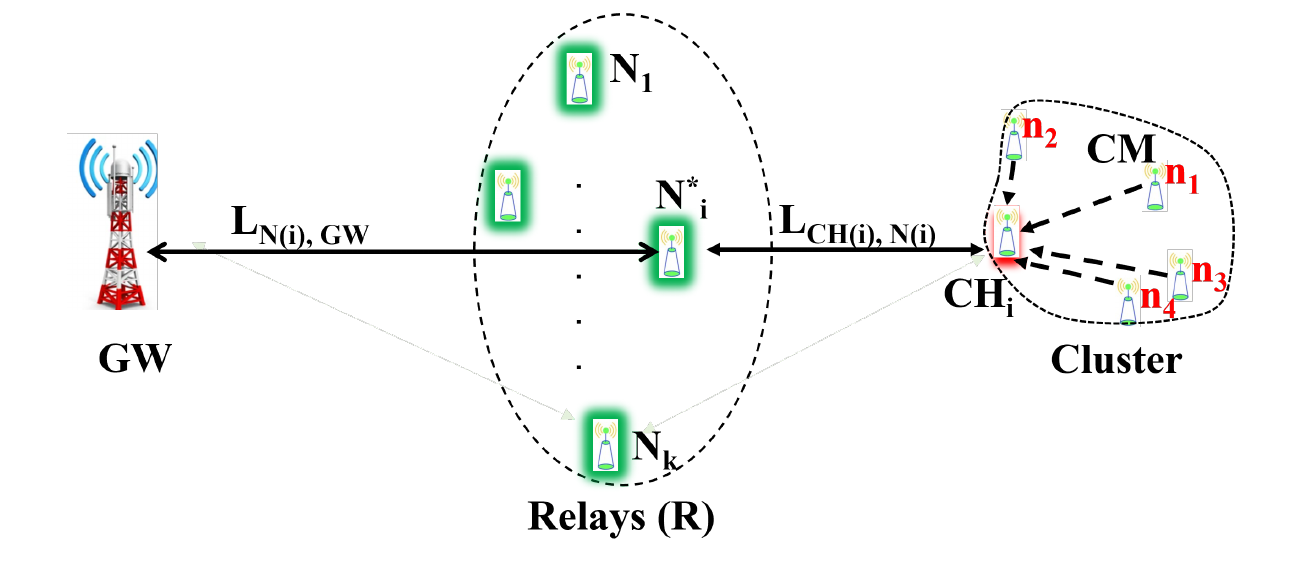
Figure 4. The relay selection